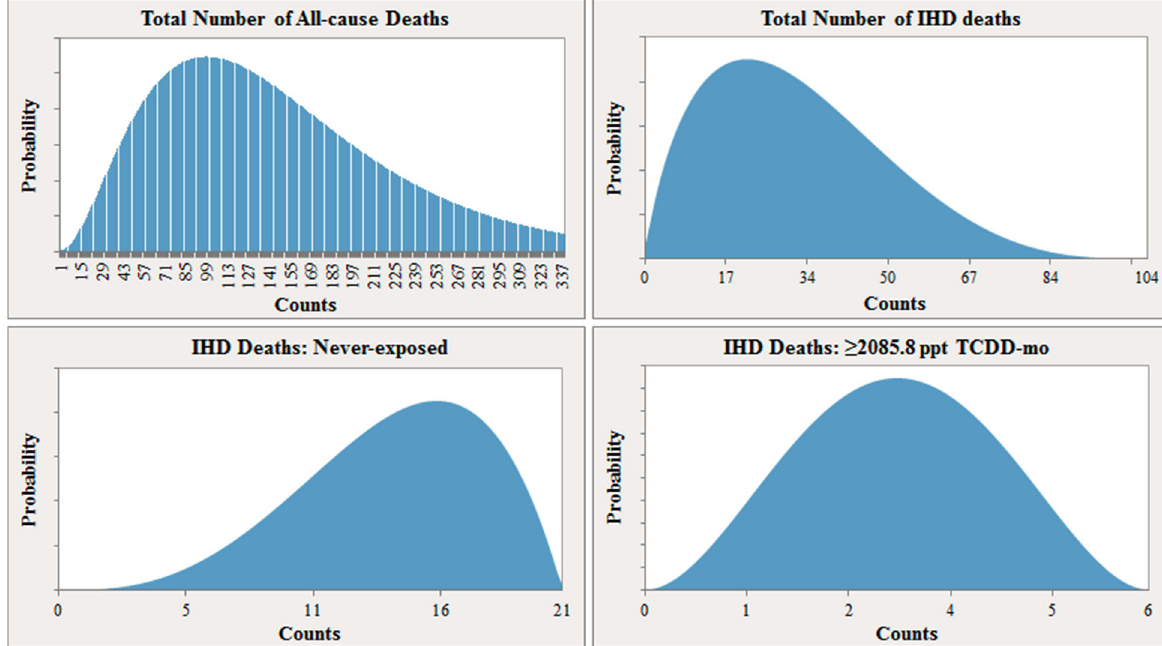
Figure 2. Example of parameter distribution input for Scenario 1.